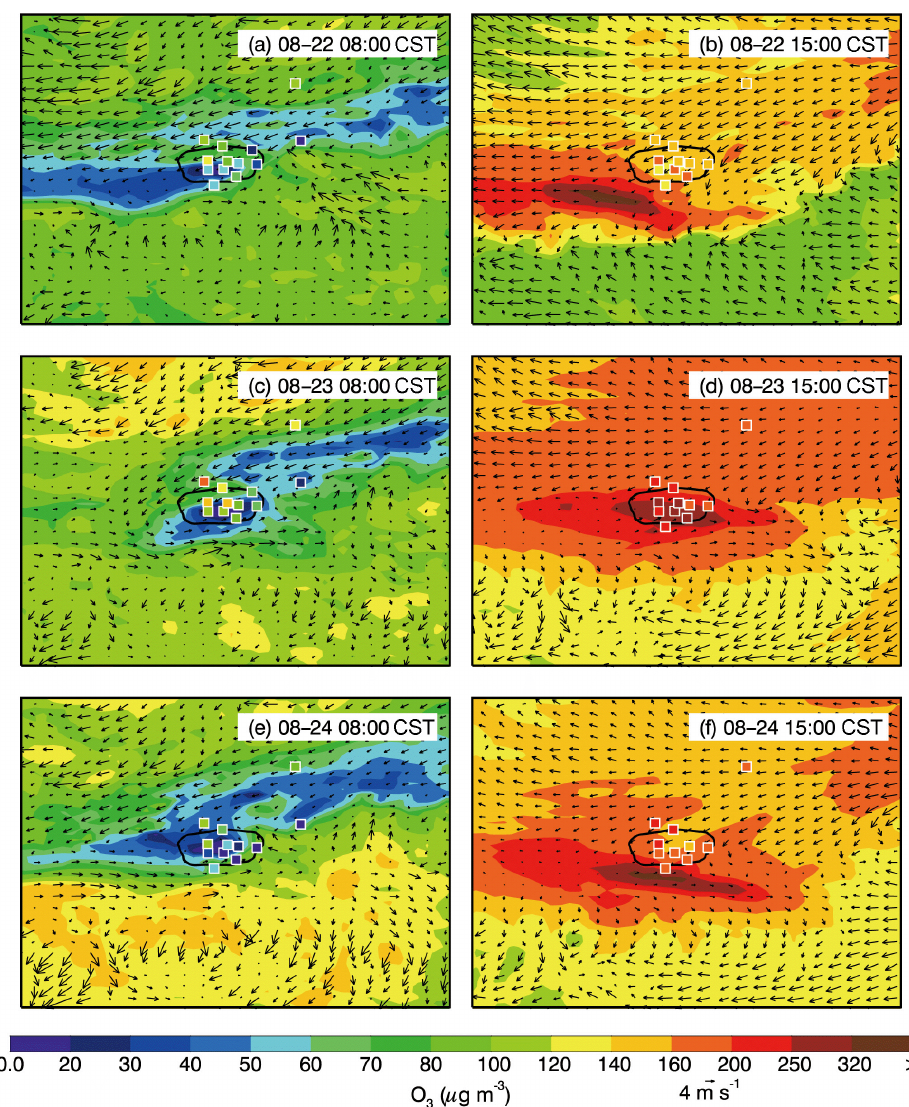
Figure 8. Pattern comparison of simulated vs. observed near-surface O 3 concentrations at 08:00 and 15:00CST from 22 to 24 August 2013. Colored squares: O 3 observations; color contour: O 3 simulations; black arrows: simulated surface